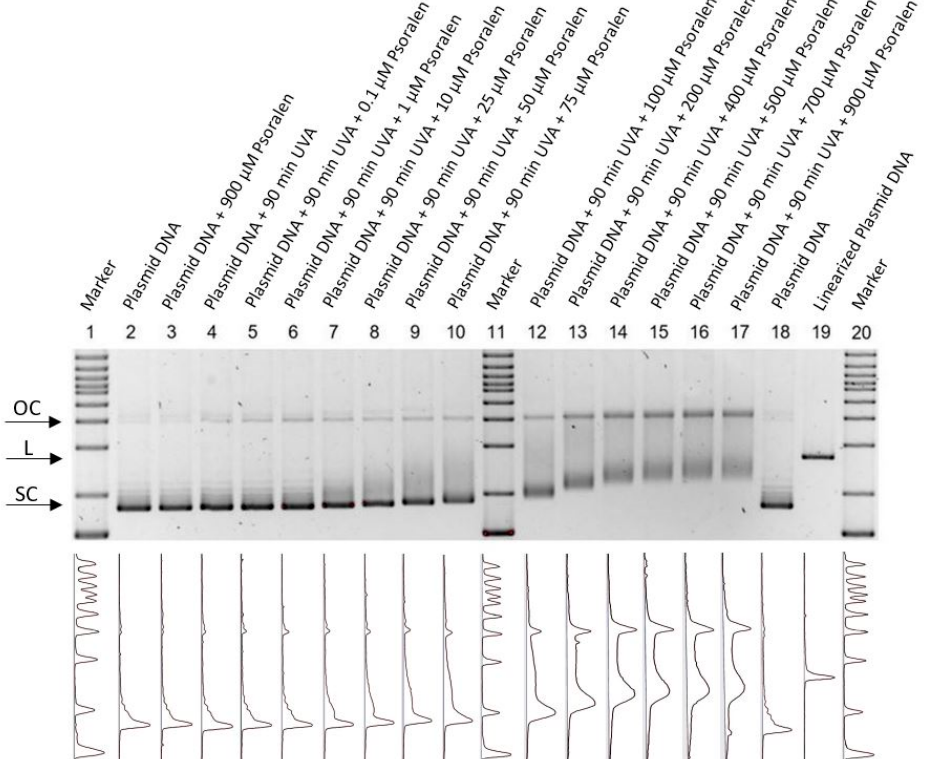
Figure 1. Fluorescent measurement of an agarose gel for combining psoralen with UV-366 nm. The aperture detects the intensity spectra ( bottom ) of the fluorescent gels and displays them visually ( top ). The figure is inverted, thus showing a dark color for high intensities. Since this measurement is not quantitative, the intensity scale only shows arbitrary units. Markers are placed in lanes 1, 11, and 20. Lane 2 and 18 show untreated plasmid DNA, whilst lane 19 contains enzymatically linearized plasmid as the control. In lanes 4–10 and 12–17, different psoralen concentrations (0, 0.1, 1, 10, 25, 50, 75, 100, 200, 400, 500, 700, 900 µM) were irradiated with UV-366 nm for 90 min. Each lane was normalized and shows the running behavior of the different setups. A higher concentration of psoralen showed a higher amount of open circular conformations (OCs). Lane 3 demonstrates non-UV-activated psoralen (900 µ